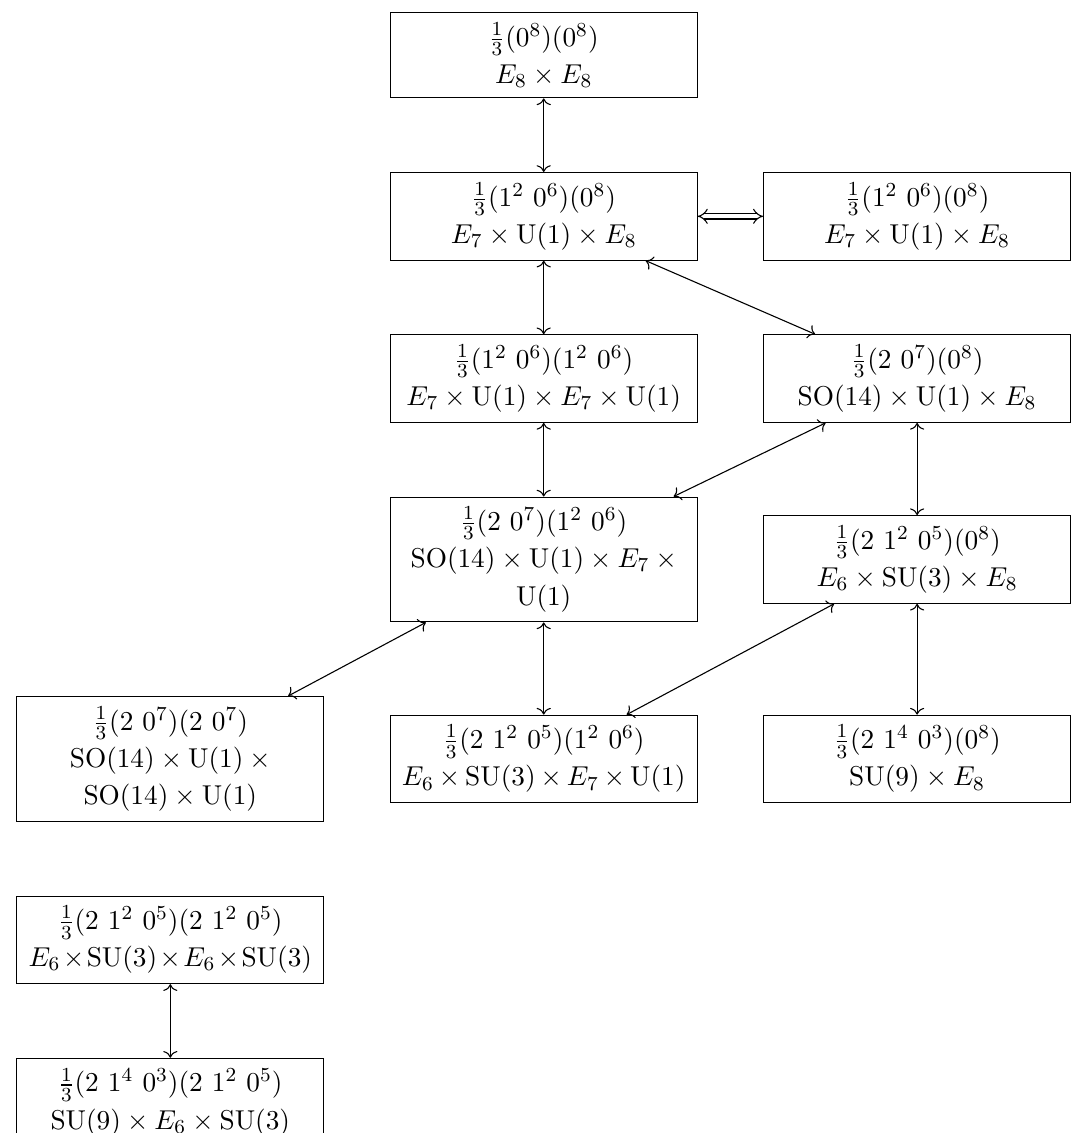
Figure 3 . Connected vacua of E 8 (cid:2) E 8 heterotic string on T 4 = Z 3 orbifold. Among (cid:12)ve perturbative models, bottommost one in each column, three generate chains of connected vacua.